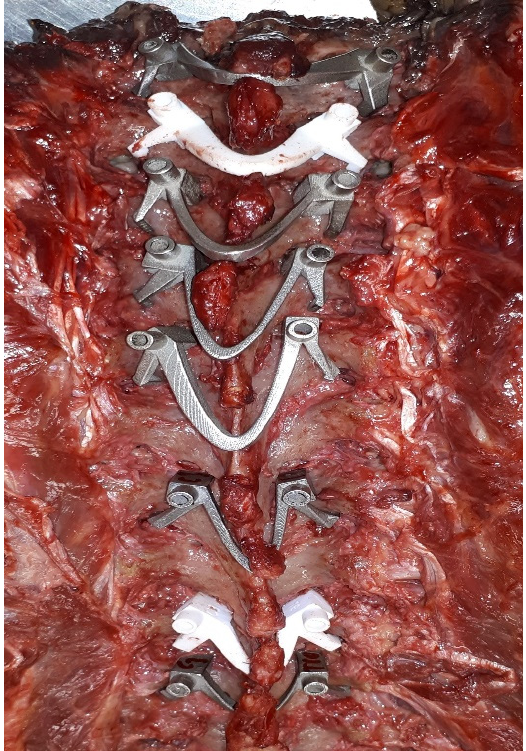
Figure 2. Examples of metal and polymer lay-on spine guides in thoracic cadaveric spine.